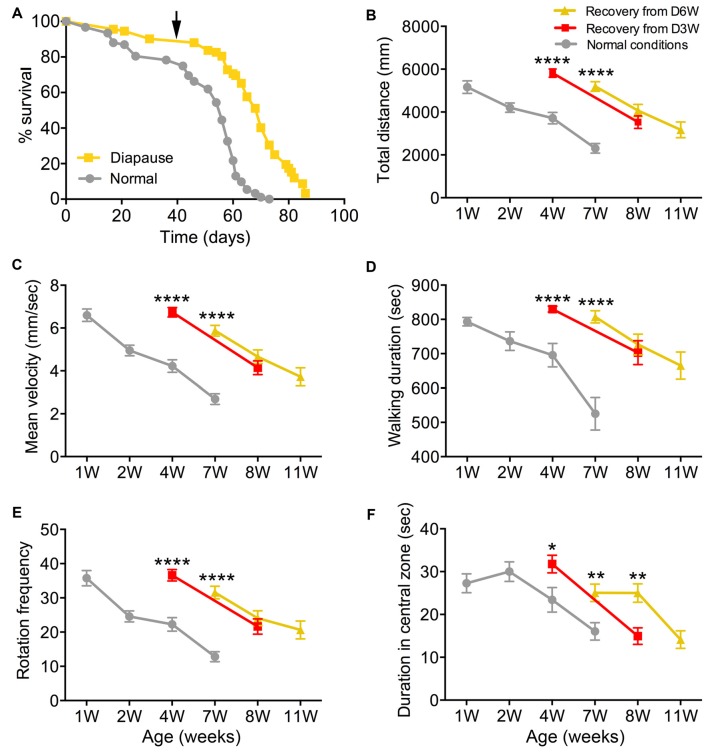
Diapause conditions delay the onset of exploratory walking senescence. (A) Survival of female flies under normal and 6 weeks diapause conditions. The arrow indicates the 6-week time point after which the diapause flies (D6W) were transferred to normal conditions. Median lifespans and sample sizes were: Normal conditions = 56 days, N = 92; and 6 weeks Diapause conditions = 70 days, N = 92. Survival curves were compared using nonparametric log rank tests. Six weeks of diapause treatment resulted in an increase in survival compared to Normal conditions (P < 0.0001) with an extension of both median and maximum lifespan. (B–F) Exploratory walking senescence for female flies of the indicated conditions run in parallel and under the same conditions as the survival experiment shown in (A). A 3-week diapause condition (D3W) was included in addition to the Normal and D6W conditions. Data are shown as mean value for each walking parameter ± SEM, N = 24–44 for the indicated conditions from three replicates. (B) Mean distance walked (mm) vs. age. (C) Mean velocity (mm/s) v/s age. (D) Mean walking duration (s) vs. age. (E) Mean frequency of rotations (change in walking direction) vs. age. (F) Mean Frequency of Central Zone visits vs. age. Data for each condition were analyzed by ANOVA and age was found to have a significant effect for all conditions (normal, D3W, D6W; p < 0.05). Planned comparisons of means were performed using Tukey HSD. For all walking parameters, no significant differences were found between 1 week old normal, 4 week old D3W and 7-week-old D6W flies (p > 0.05). At 4 weeks, D3W flies performed significantly better than 4-week-old normal flies. At 7 weeks, D6W flies performed significantly better in all parameters than 7-week-old normal flies. ****Indicates significant difference between diapause treated and normal flies, p < 0.0001. **Indicates significant difference between diapause treated and normal flies, p < 0.01. *Indicates significant difference between diapause treated and normal flies, p < 0.05.